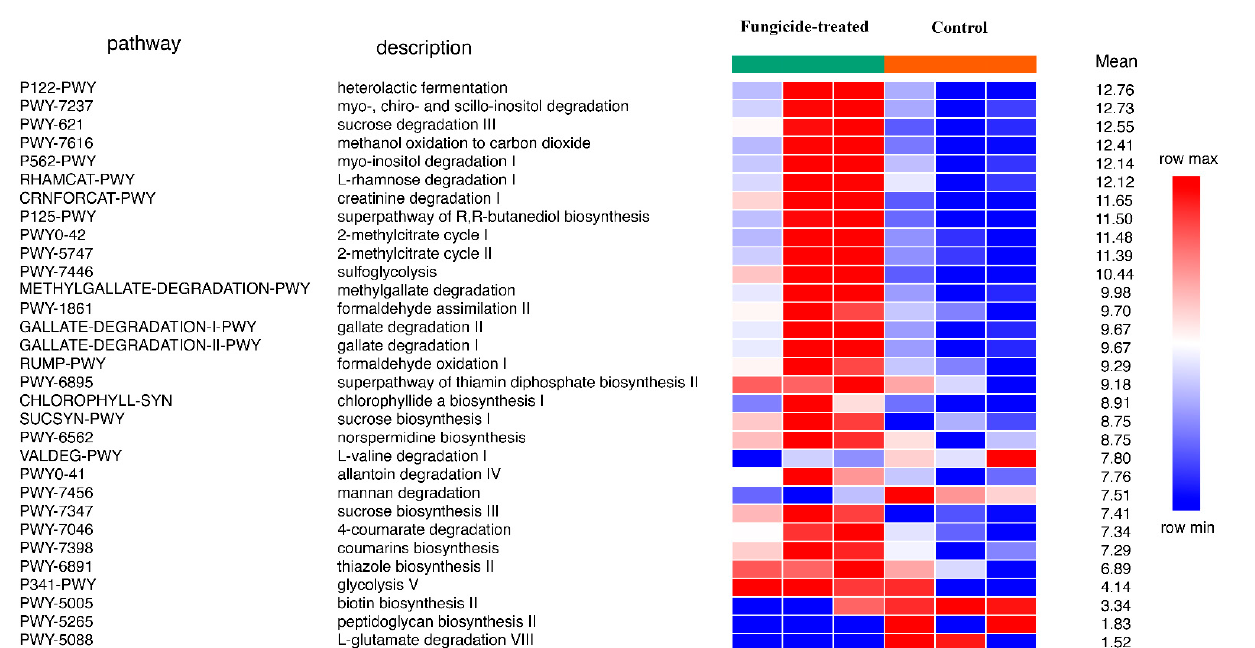
Figure 3. Box plots of the Shannon and Chao1 alpha-diversity indices of bacterial communities for the fungicide-treated and the control soils. The data represent means of three replicate sequencing